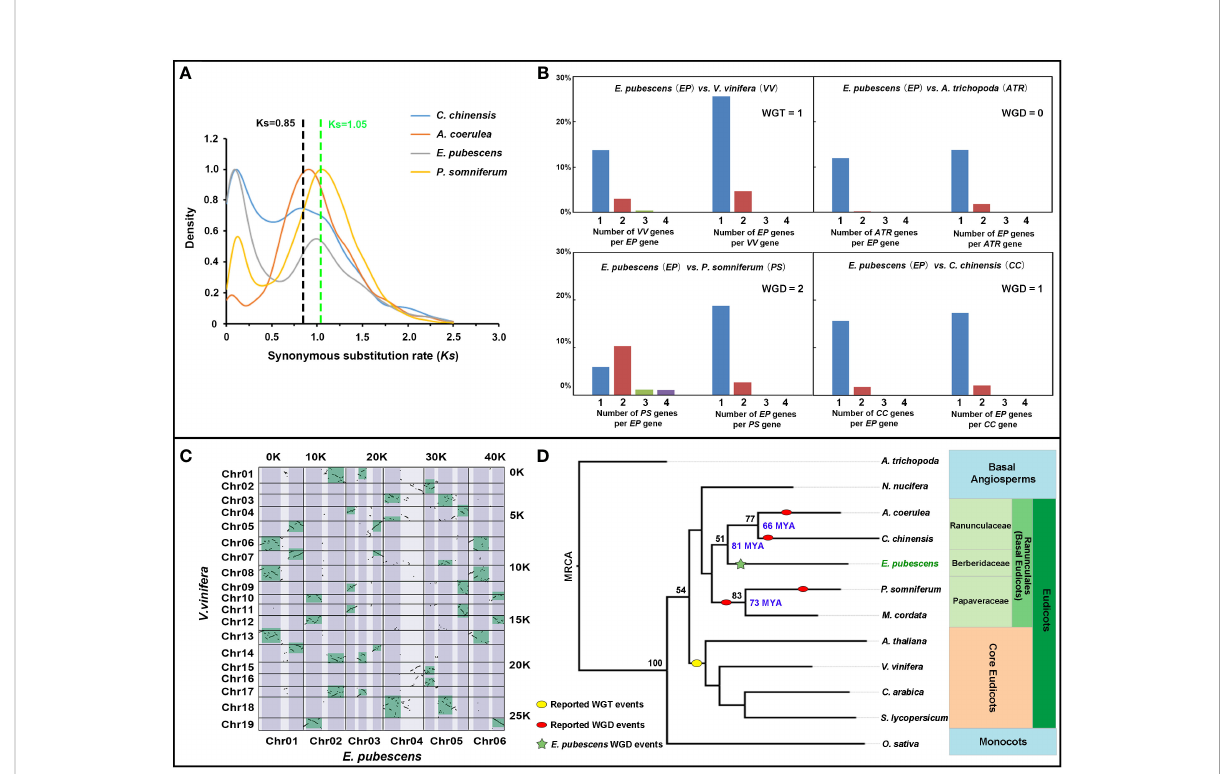
FIGURE 3 Comparative genomic analysis of E. pubescens and other species. (A) Ks plots of orthologous genes in the genome of C . chinensis , A. coerulea , E . pubescens , and P. somniferum . Blue, red, light purple and yellow curves represent C . chinensis , A. coerulea , E . pubescens and P. somniferum respectively. (B) Comparison of orthologous gene ratio of E . pubescens to Vitis vinifera, P. somniferum , Amborella trichopoda , and C . chinensis , reciprocally. Blue, red, green and purple bars represent one, two, three and four orthologous genes. Short names were assigned as EP ( E. pubescens ), VV ( V. vinifera ), ATR ( A. trichopoda ), PP ( P. somniferum ) and CC ( C. chinensis ). Top left is the comparison of orthologous gene ratio of EP to VV ; top right, the comparison of orthologous gene ratio of EP to ATR ; bottom left, the comparison of orthologous gene ratio of EP to PP ; bottom right, the comparison of orthologous gene ratio of EP to CC . (C) Dotplot of syntenic blocks between E . pubescens and V. vinifera . Chromosomes of V. vinifera and E . pubescens were labeled on the Y-axis and X-axis respectively; the number of syntenic blocks from V. vinifera and E . pubescens was labeled on the right and top respectively; syntenic blocks with 3:1 ratio of V. vinifera to E . pubescens were green-colored on the dotplot. (D) Phylogenetic tree of 12 plant species. In phylogenetic tree, red and yellow ovals represent the reported WGD events and WGT- g event, respectively; the green star highlighted the independent WGD event in E . pubescens ; ML (Maximum Likelihood Method) bootstrap values were labeled on the left of key phylogenetic tree nodes in black and the divergence times were labeled on the right of key phylogenetic tree nodes in blue, based on Timetree online services. Based on APG IV system, the phylogenetic classi fi cation of 12 plant species was labeled on the right of phylogenetic tree with different background